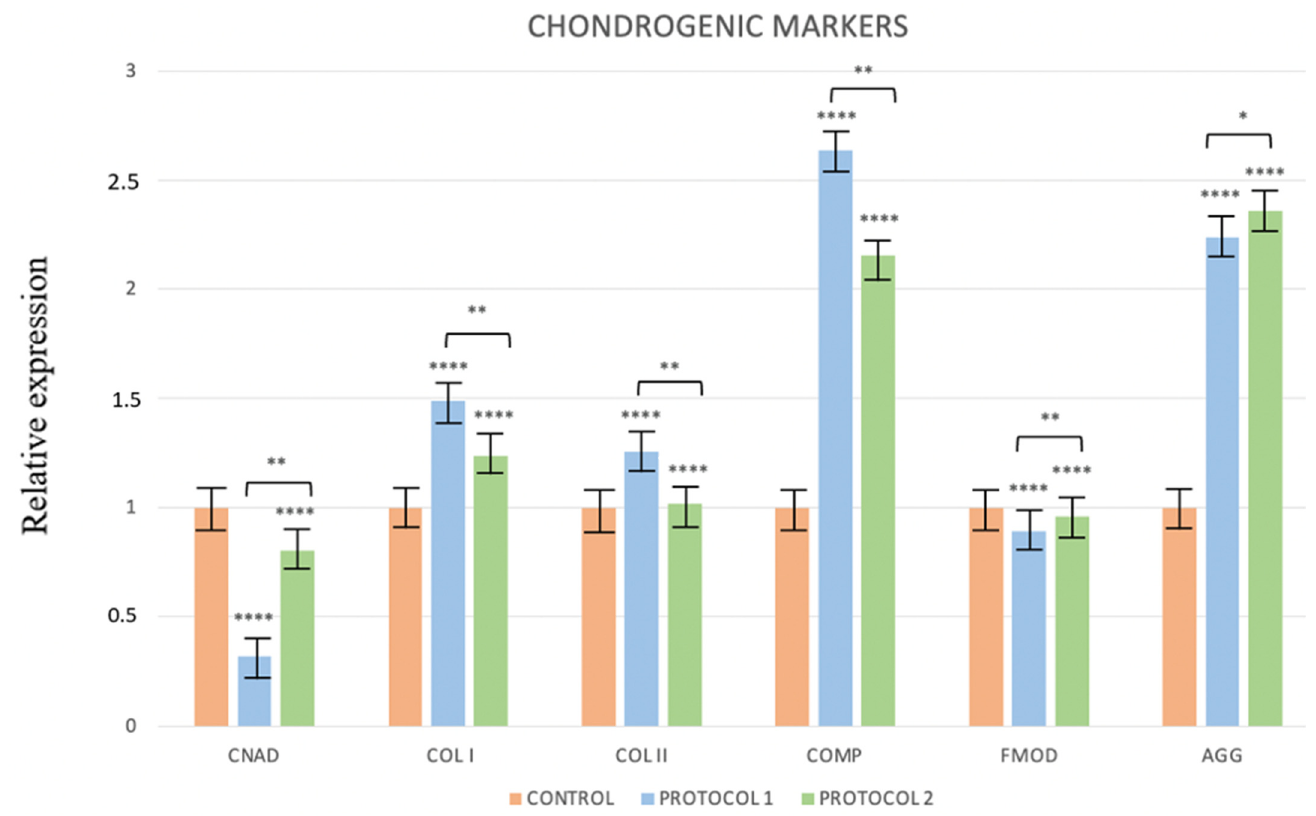
Figure 5. Change in the expression of chondrogenic markers in Protocols 1 and 2. * p ≤ 0.1, ** p ≤ 0.01, **** p ≤ 0.0001.